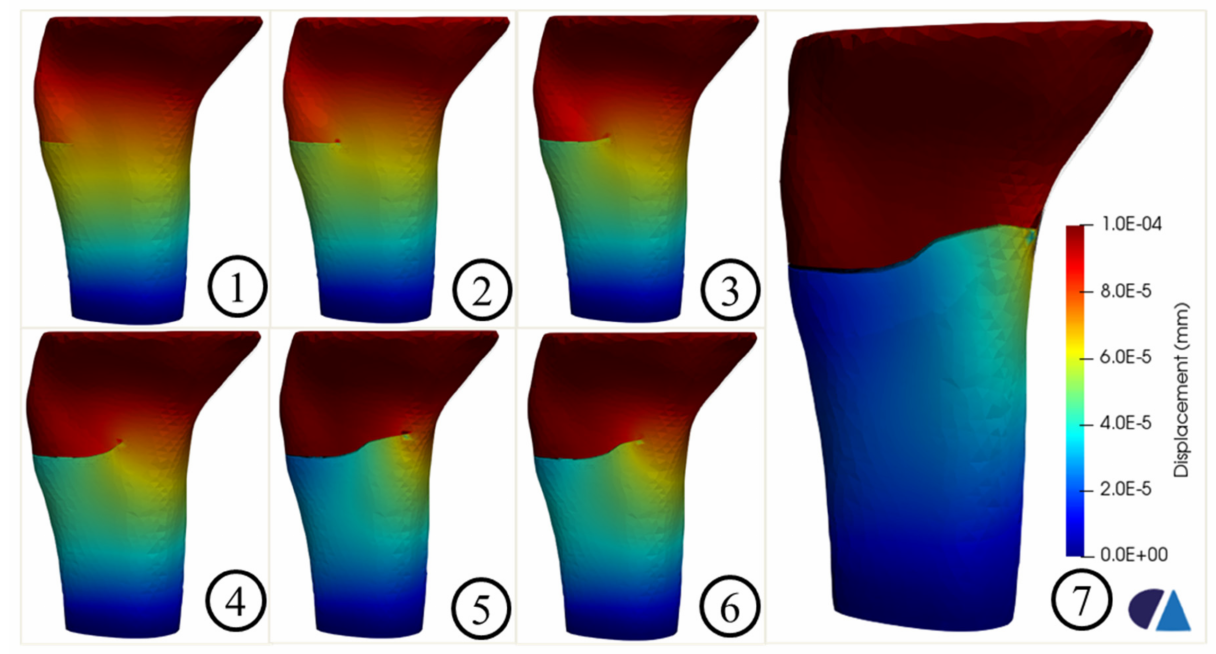
Figure 8. Crack propagation in the tibia model without the